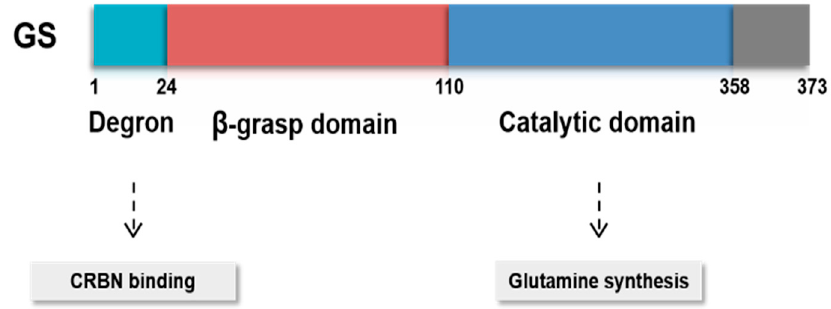
Figure 2. Functional domains of GS. GS possesses β -grasp domain and glutamine synthetase catalytic domain. Cereblon (CRBN) binds to GS degron, regulating its protein stability under sufficient glutamine level.